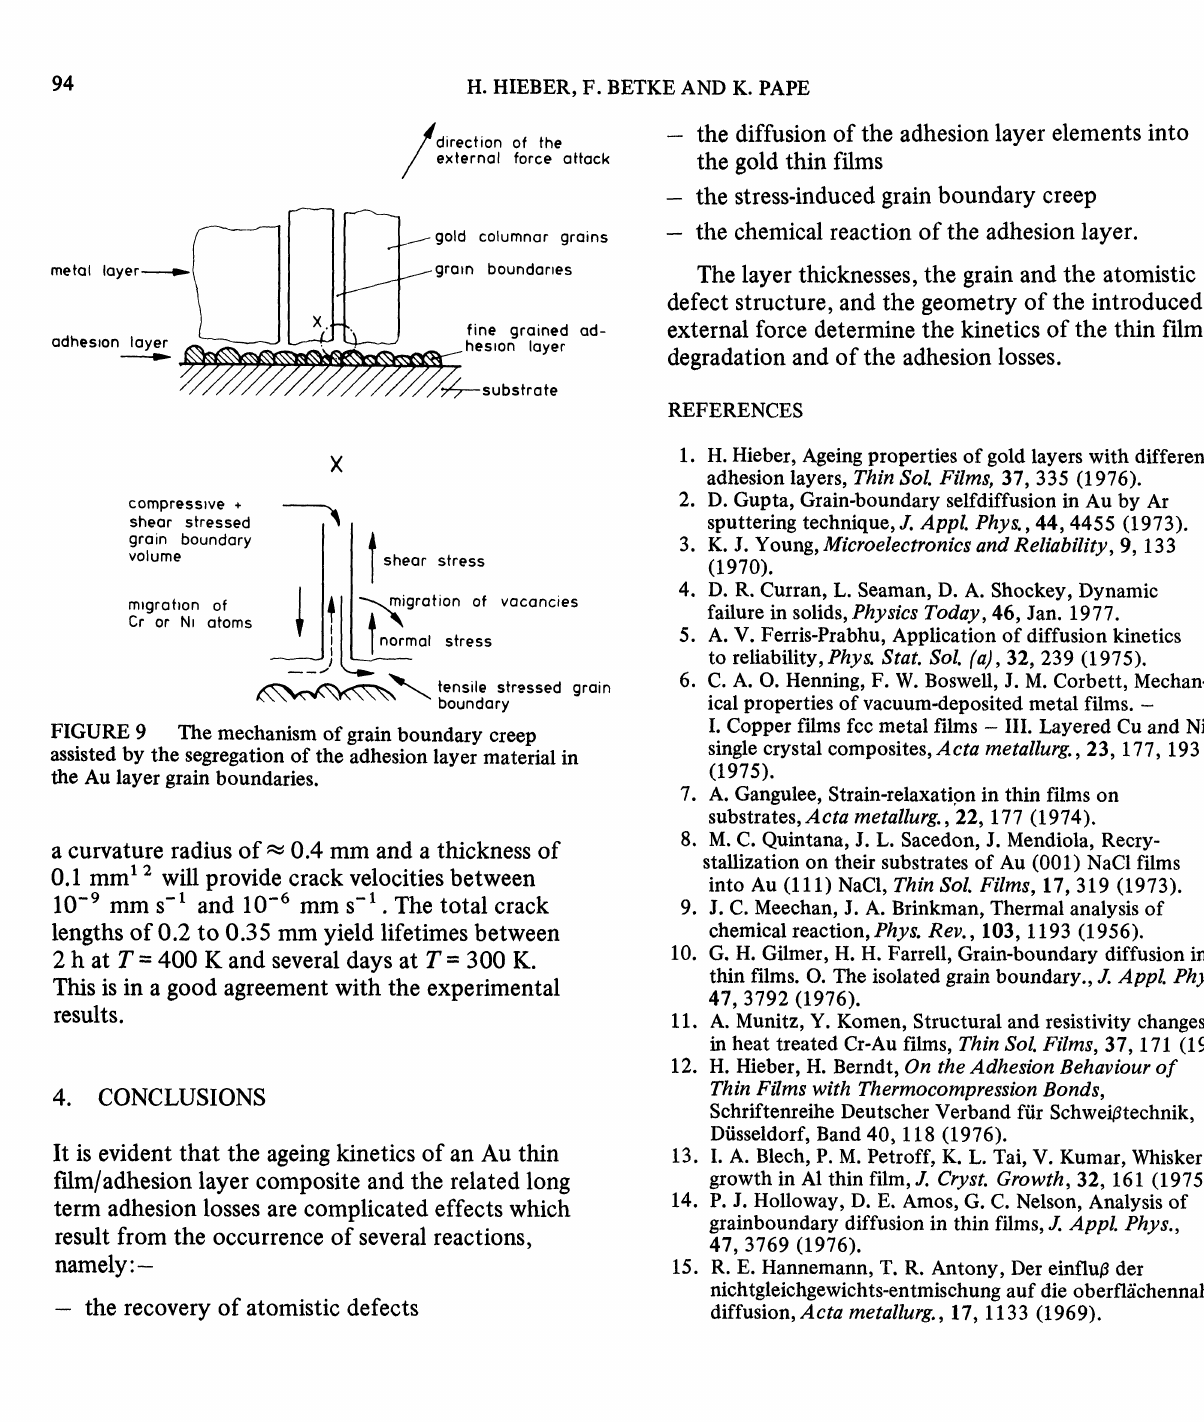
The mechanism of grain boundary creep assisted by the segregation of the adhesion layer material in the Au layer grain